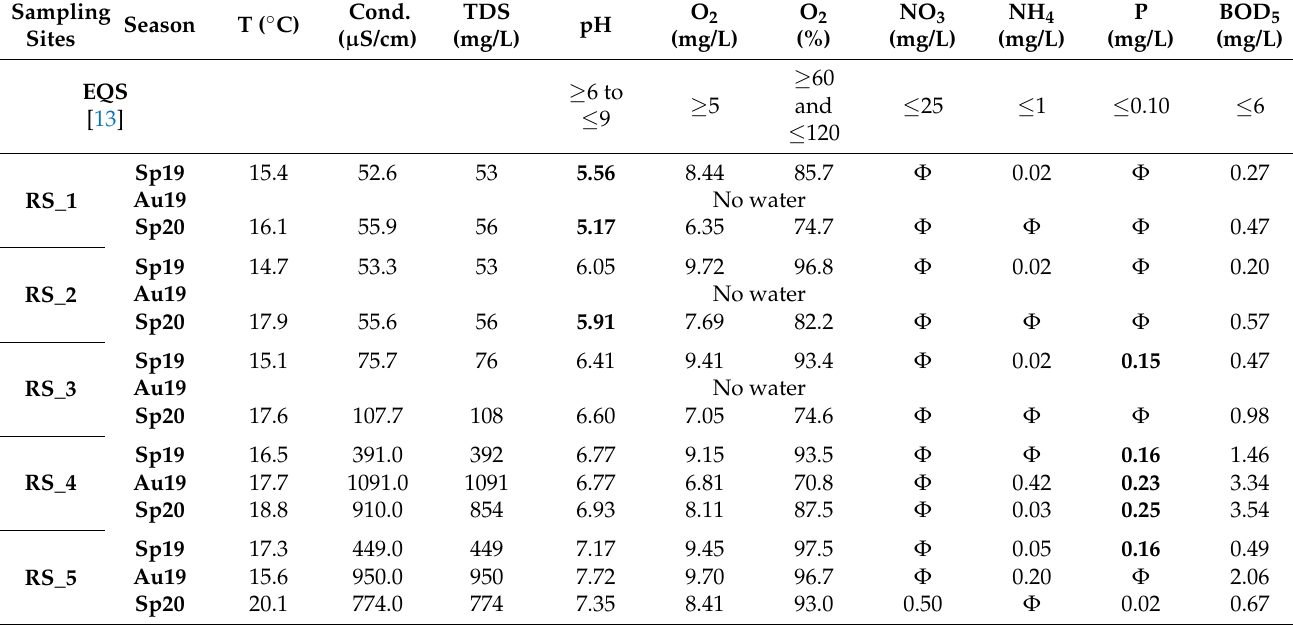
Table 1. Results of physical and chemical parameters: temperature (T), conductivity (Cond), total dissolved solids (TDS), pH, dissolved oxygen (O 2 ), nitrates (NO 3 ), ammoniacal nitrogen (NH 4 ), and total phosphorus (P) and biochemical oxygen demand (BOD 5 ), for each sampling site for the three sampling periods. Environmental quality standards (EQS) values indicated by the WFD to achieve “Good ecological status” in small northern rivers were also included. Bold values show those that exceed the EQS stipulated for the respective